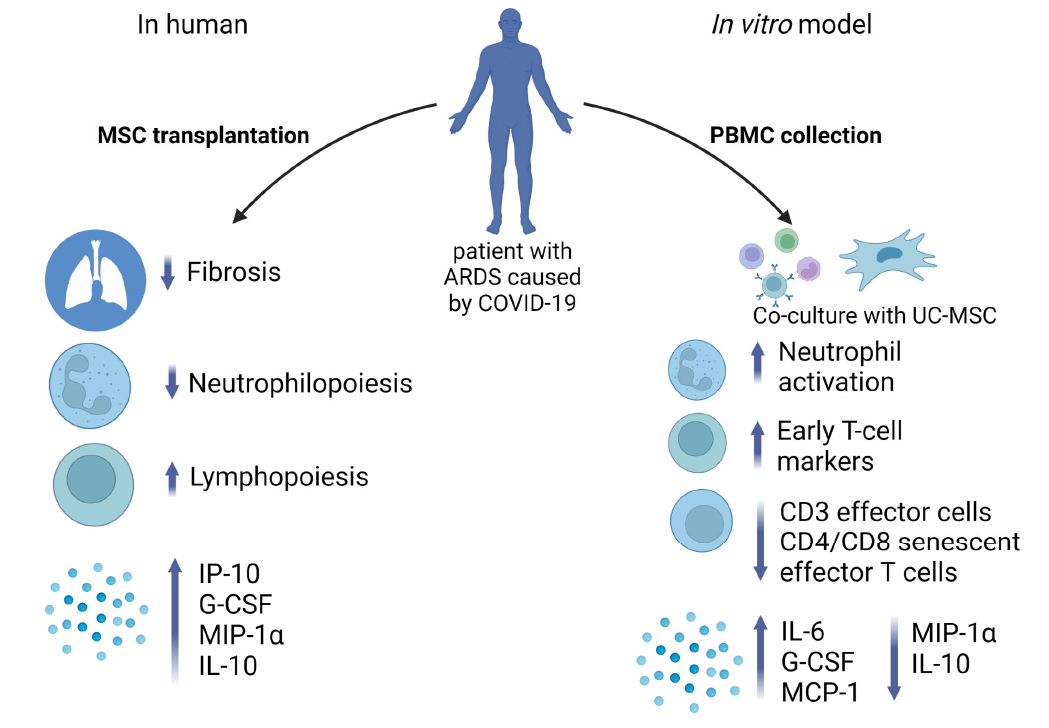
Figure 7. Immunomodulation effect of UC-MSC in vivo and in vitro. UC-MSC after transplantation in patients with ARDS caused by COVID-19 led to the reduction of lung tissue fibrosis and neutrophil count, stimulating lymphopoiesis and production of proinflammatory cytokines. In vitro model of PBMC co-culture with UC-MSC revealed abundance in neutrophil activation, early T-cell marker expression, and cytokine production, whereas counts of effector T cells and senescent effector CD4 and CD8 cells declined. Created with BioRender.com (accessed on 14 February